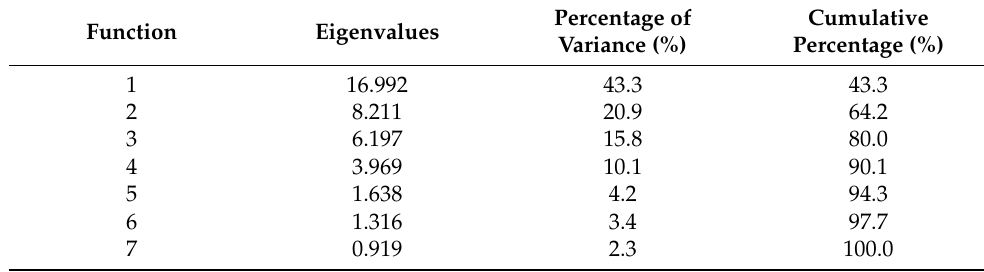
Table 5. Eigenvalues and variances of